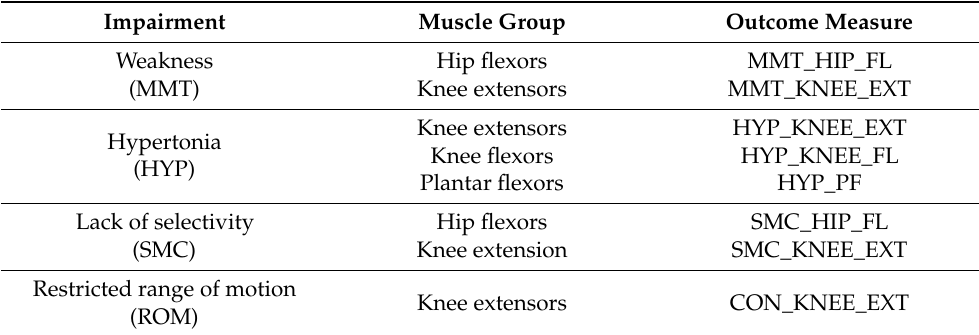
Table 1. Impairment outcome measures (MMT, HYP, SMC, CON measures) involved in knee flexion in terminal stance, pre-swing and initial swing